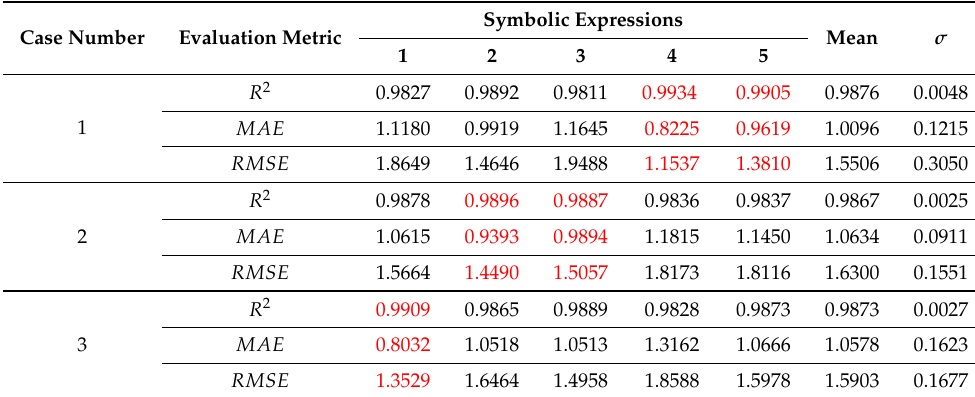
Table 7. The performance metric values obtained on the test